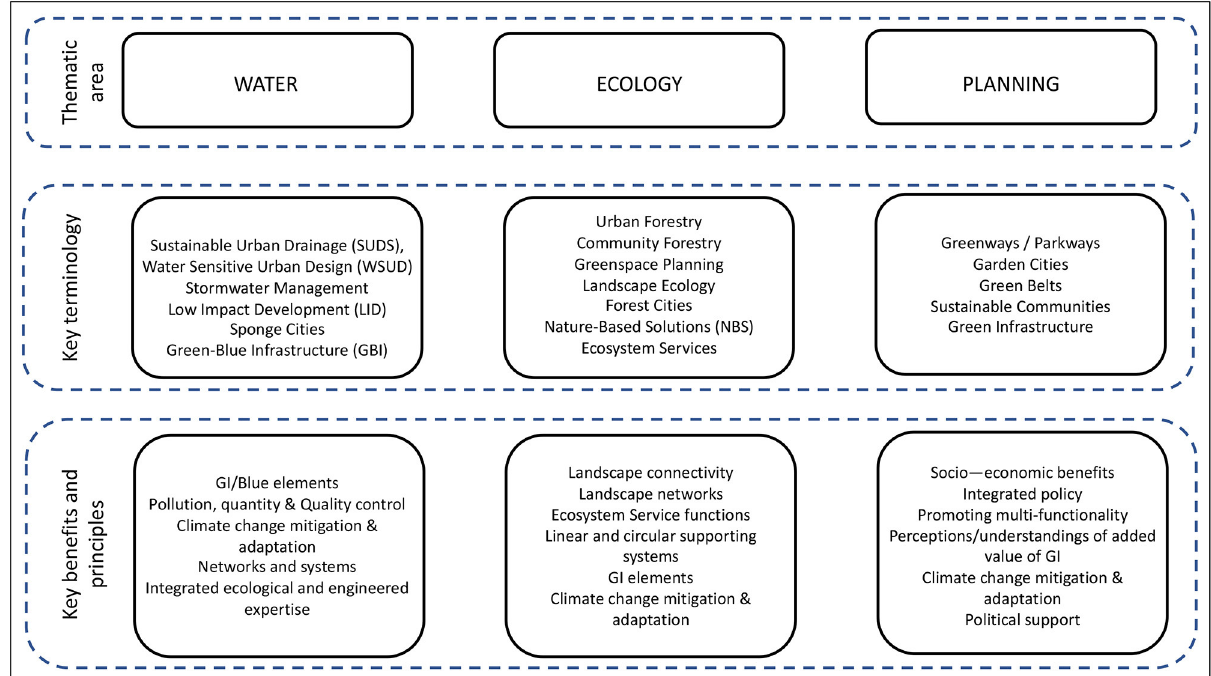
FIGURE 1 | Intersection of GI principles and